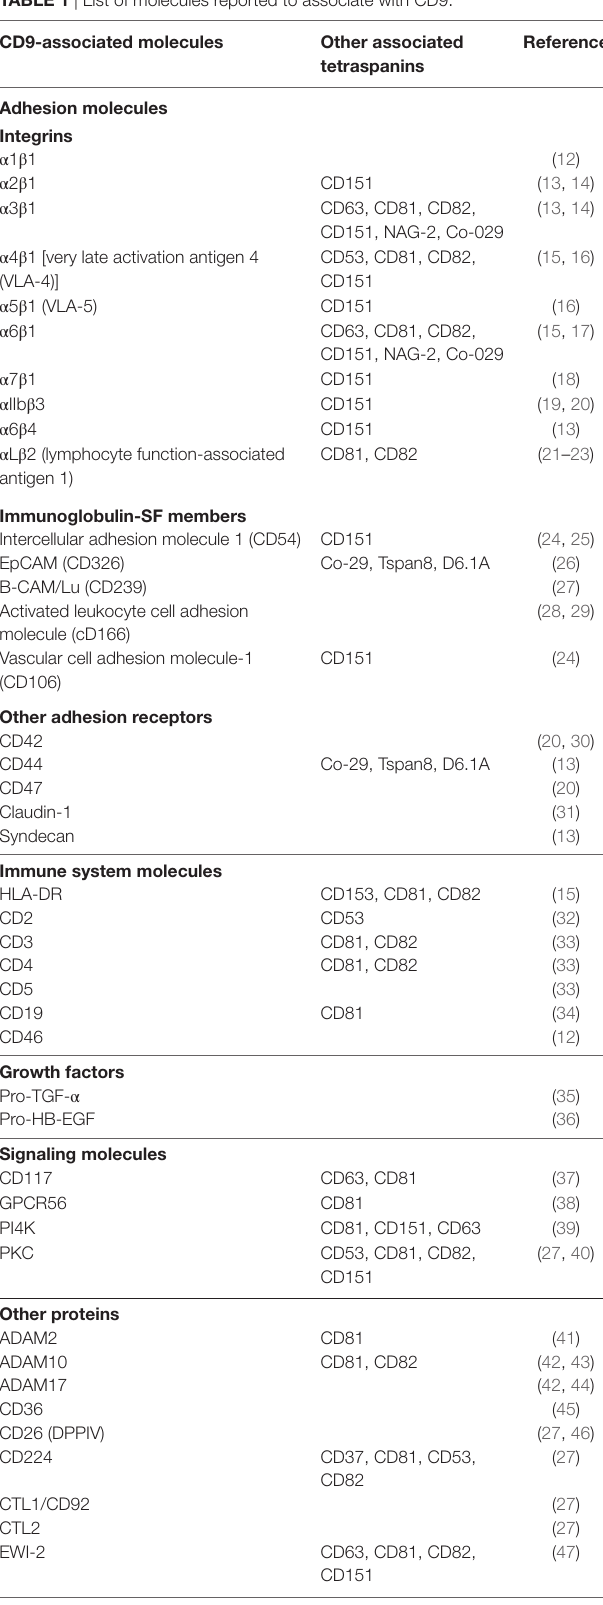
TABLe 1 | List of molecules reported to associate with CD9. CD9-associated molecules Other associated tetraspanins